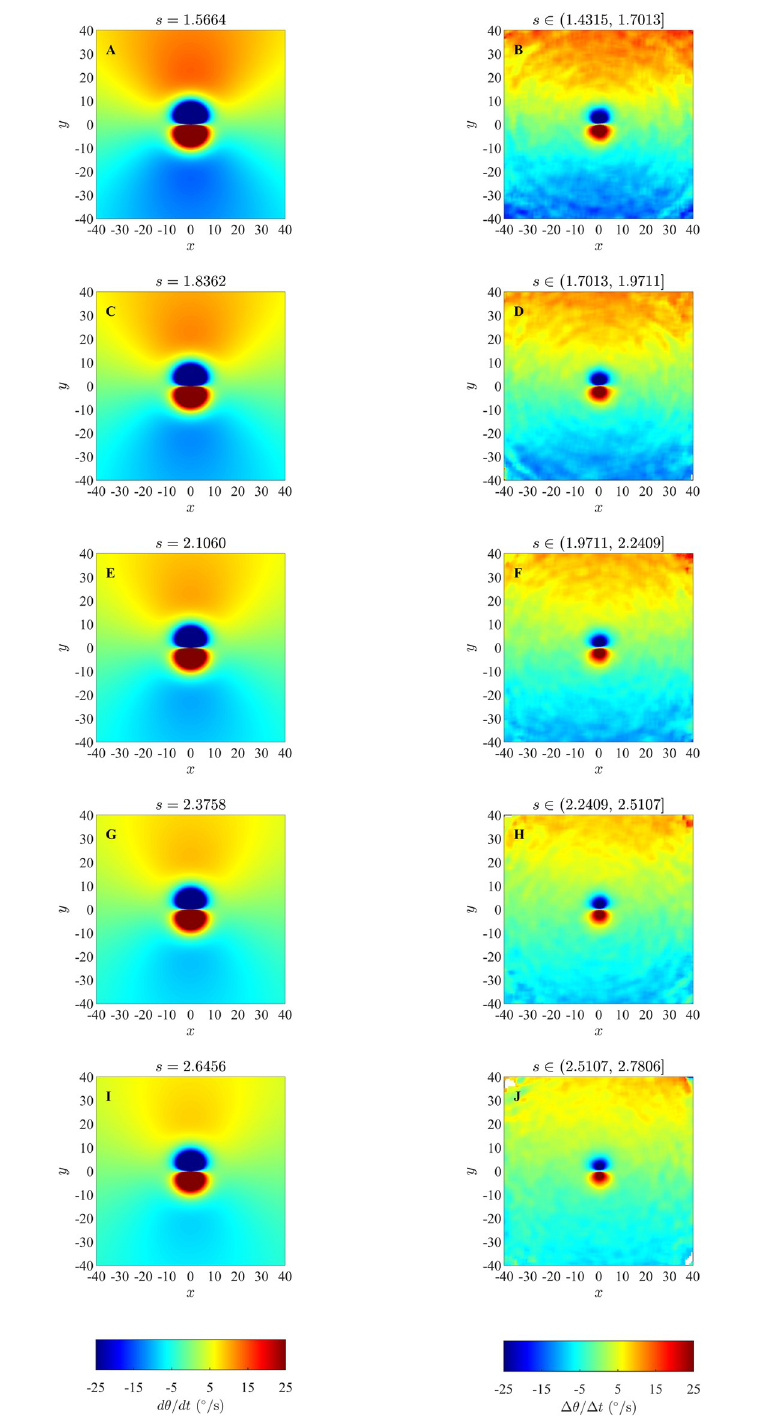
Fig 8. Left column: analytical pairwise turning interactions as prescribed by the ODE model (equation (S3.19)) for groups that form swarms (item (b) from Table 3). Right column: results obtained via the averaging method. Here the independent variables are relative partner positions (within each graph) and the speed of the focal individual (which varies across the five panels above). In each of the graphs the focal individual is located at the origin and moving right along the positive x -axis. Positive changes in angle/direction correspond to anti-clockwise/left turns, whereas negative changes in angle/direction correspond to clockwise/right turns. White regions indicate that no partner individuals were recorded with the corresponding relative ( x , y ) coordinates for the given range of speed for focal individuals. (Derived from simulations with N = 10 individuals over 10000 time steps).